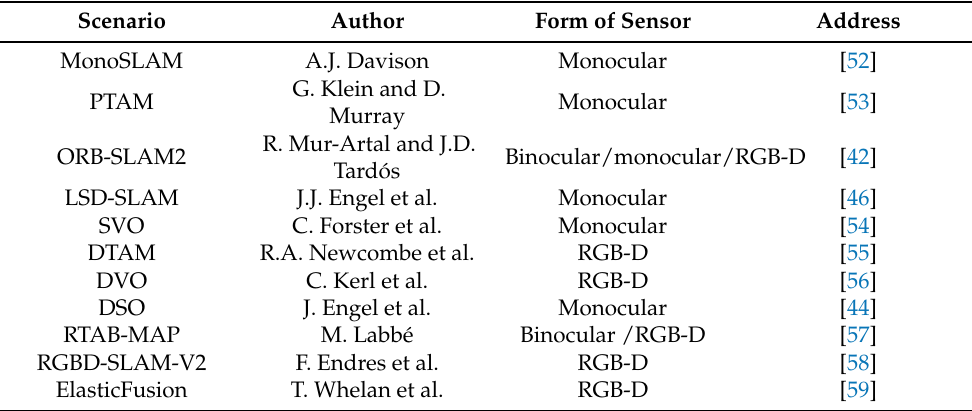
Table 2. Common algorithms in visual